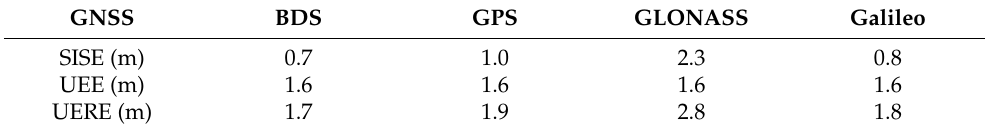
Table 1. UERE evaluation.